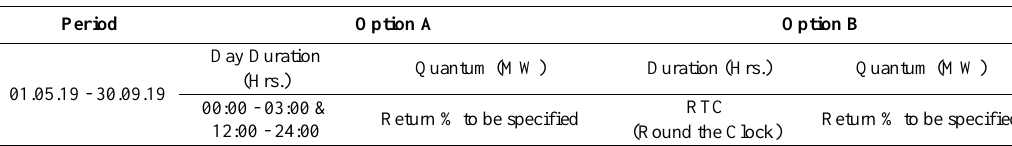
Table 1. Supply of power by utility A to Utility B